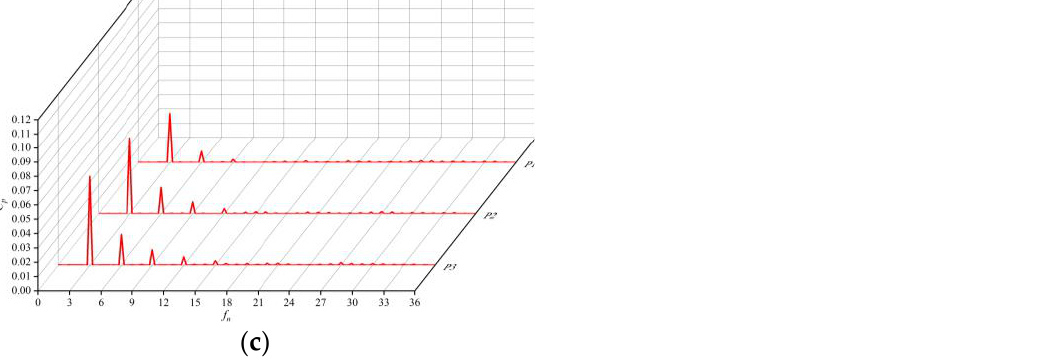
Figure 18. Frequency domain diagram of C p at impeller inlet: ( a ) Q = 0.8 Q bep ; ( b ) Q = 1.0 Q bep ; ( c ) Q = 1.2 Q bep .